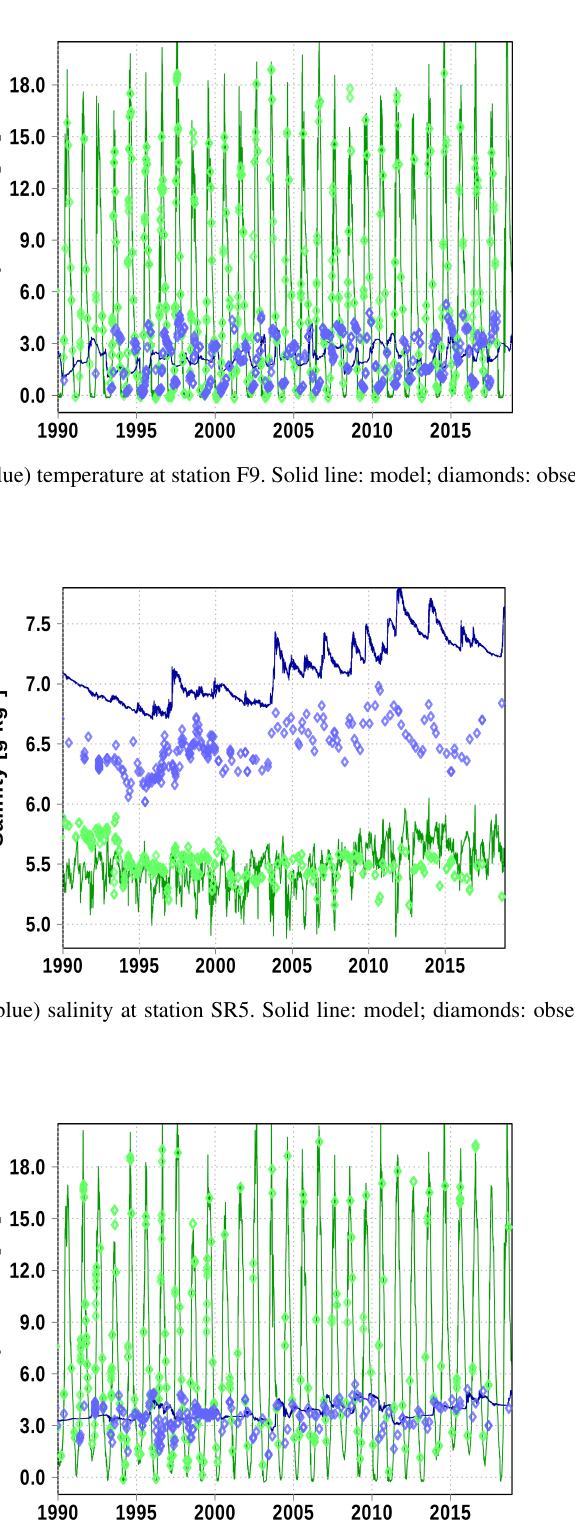
Figure A6. Surface (green) and bottom (blue) temperature at station SR5. Solid line: model; diamonds: observations (http://www.ices.dk, last access: 19 June